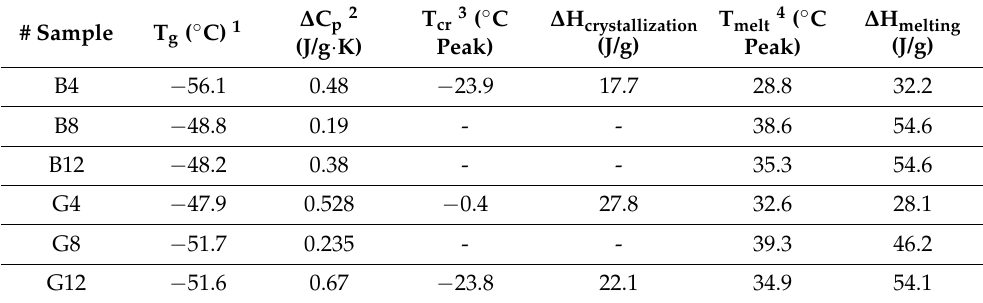
Figure 6. Differential scanning calorimetry analysis of ( a ) CD-PEG and ( b ) CDLA-PEG hydrogels. Table 3. DSC data for CD- and CDLA-PEG